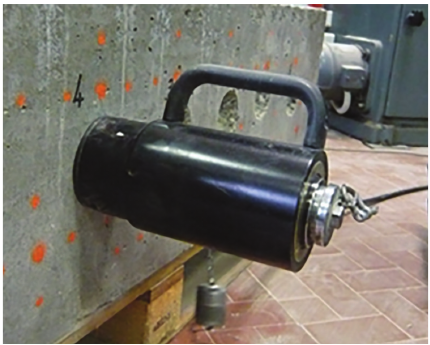
Figure 9: Pull-out of unloaded concrete.